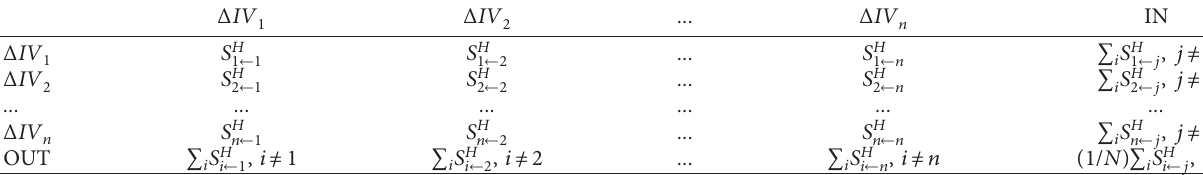
Table 1: Definition of risk spillover